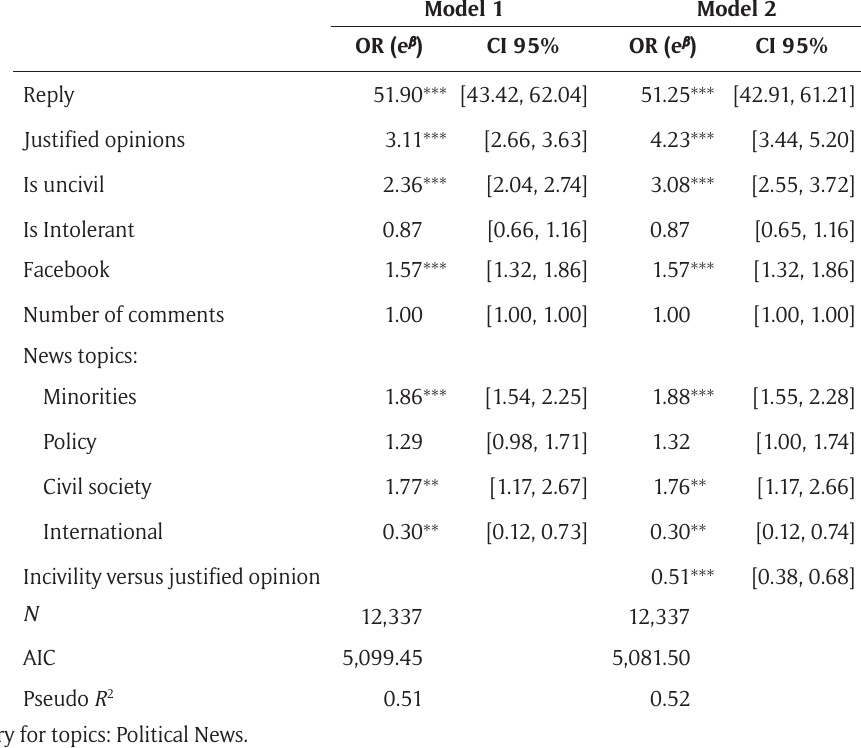
Table 3: Logistic regression predicting disagreement in online